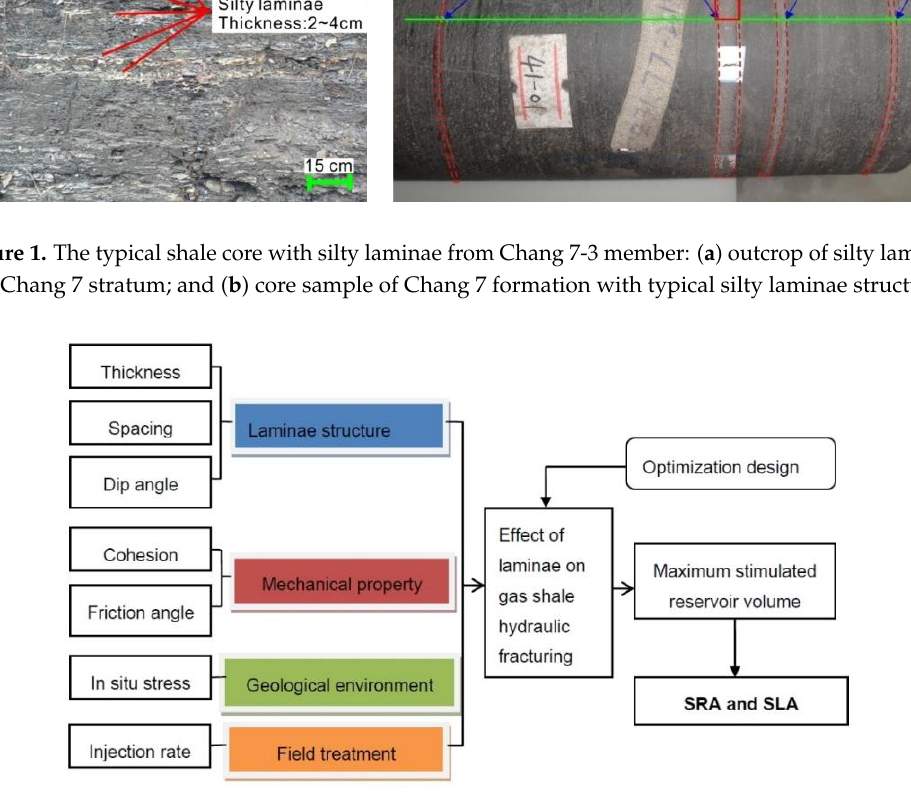
Figure 2. The flow chart for the multiple parameters evalation and optimization to silty laminae shale formation.